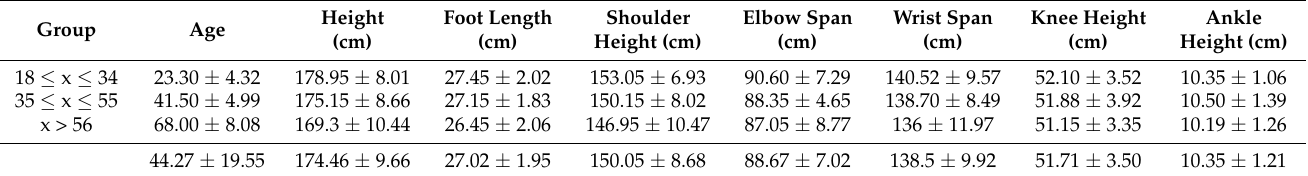
Table 1. Anthropometric measurements of participants divided by groups and total. Values are mean ± standard